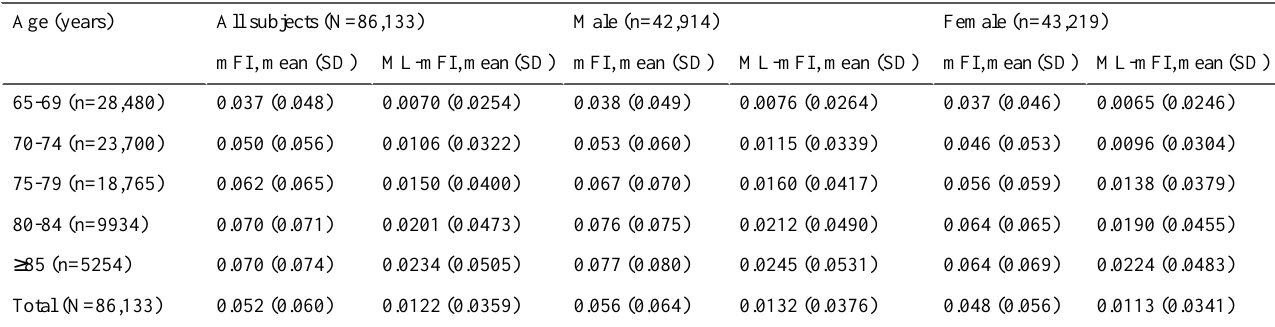
Table 1. Comparisons of mFI and ML-mFI by age and sex.